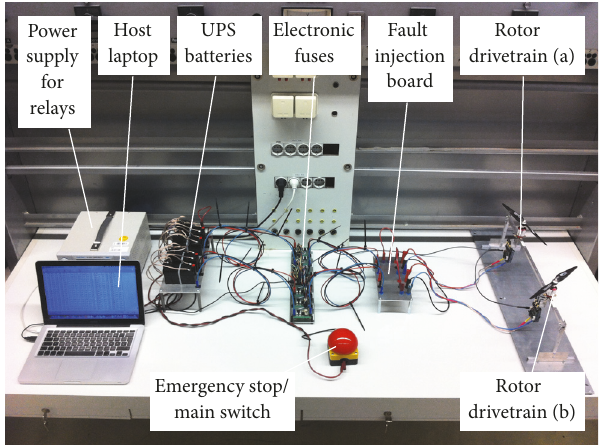
Figure 14: Proof-of-principle demonstrator setup in